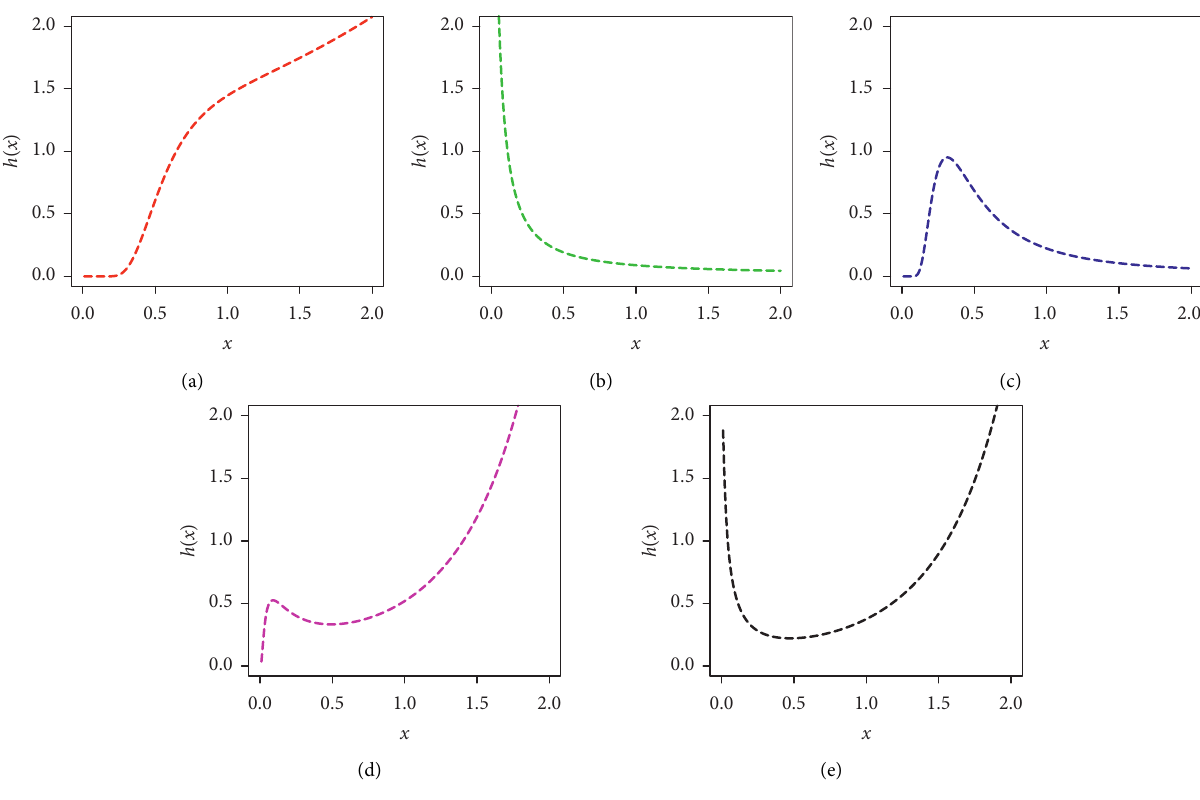
Figure 3: Different HRF plots of the ASNFEW